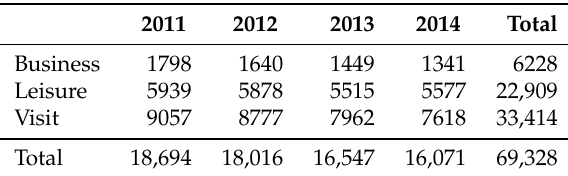
Table 1. Sample size by trip